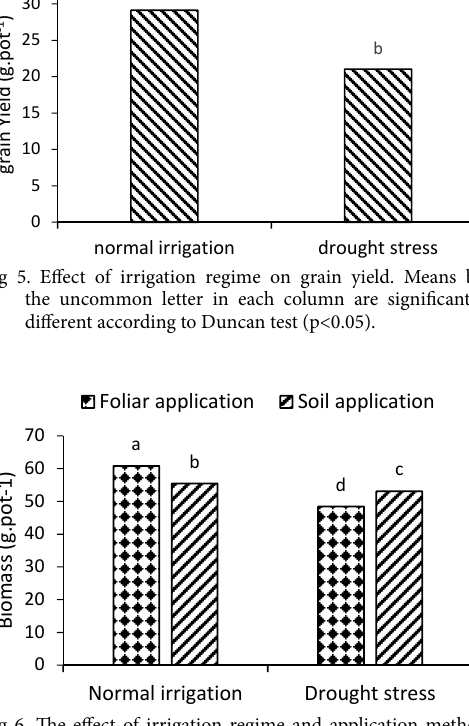
Fig 6. The effect of irrigation regime and application method on biomass. Means by the uncommon letter in each column are significantly different according to Duncan test